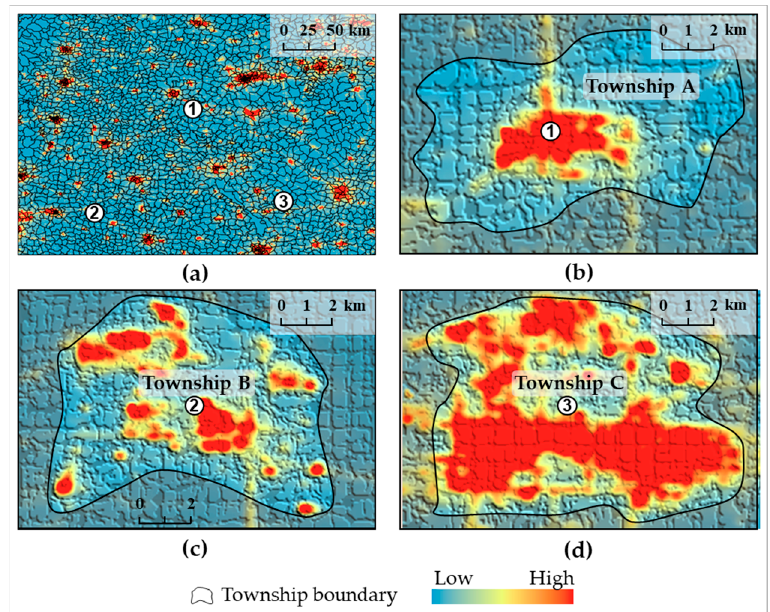
Figure 3. Spatial patterns of township nightlight distribution: ( a ) Close-up view of the nighttime light distribution of the townships; ( b ) Single-core nighttime light distribution; ( c ) Discrete clumps of nighttime light distribution; ( d ) Concentrated-bright nighttime light distribution.